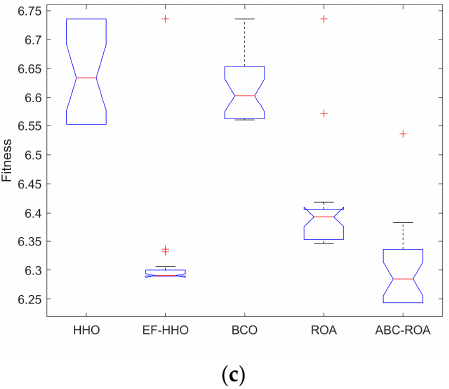
Figure 10. ANOVA of the designed method for privacy preservation over the Ethereum network regarding fitness function ( a ) dataset 1, ( b ) dataset 2, and ( c ) dataset 3.